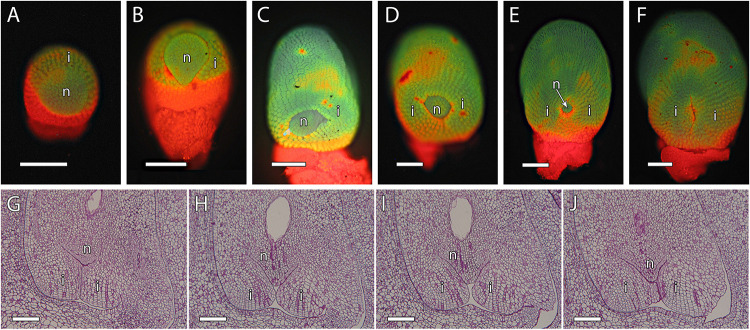
Integument development in mango ovules. (A) Early stage of ovule development showing the emerging integument. (B–F) At later stages, the nucellus is gradually surrounded by the integument. (G–J) Serial 2-μm resin sections of the micropyle at anthesis. (A–F) Acridine orange staining of squash preparation. (G–J) PAS staining. N, nucellus; I, integument. Scale bars, 100 μm.